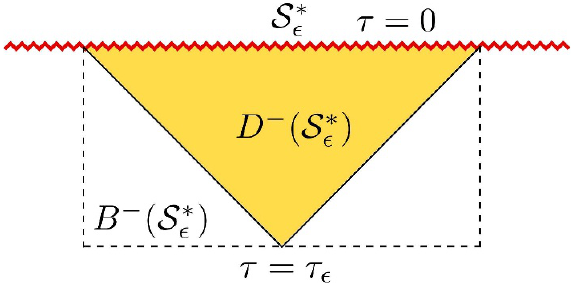
Figure 9 . Comparison between the ǫ -box and the past domain of dependence of S ∗ ǫ